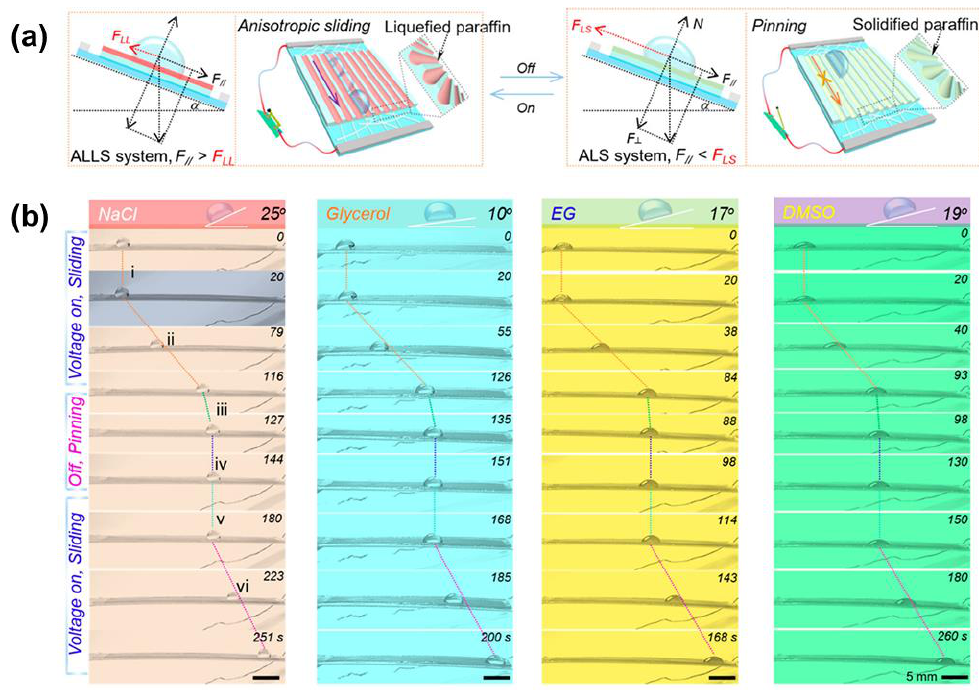
Figure 5. ( a ) Schematic of the mechanism to manipulate droplets thermally. The energized nanowire produces the joule heat to melt the paraffin and forms a liquified slippery paraffin layer with low friction. In this case, F > f, F and f refers to the driving force along the slope induced by gravity and friction force, respectively. This enables the droplet sliding. When the voltage is off, the liquid paraffin solidifies, so the friction increases, leading to the droplet pinning. ( b ) Demonstration of various droplets (NaCl, glycerol) manipulation, including NaCl, glycerol, ethylene glycol, dimethyl sulfoxide. Reprinted with permission from [39]. Copyright (2020) American Chemical Society.